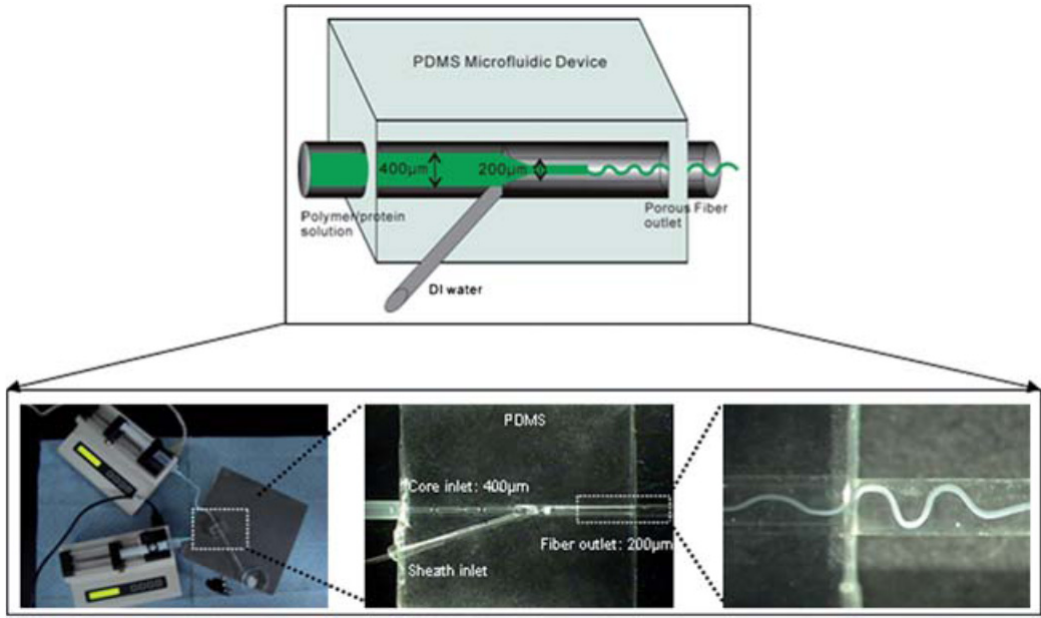
Figure 38. Schematic illustration of fiber fabrication using the microfluidic device